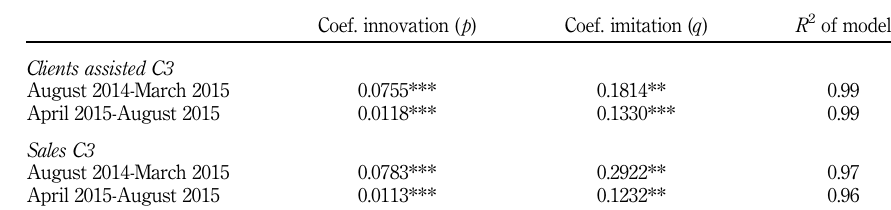
Table V. NLLS Estimation for the C3 over the three sub